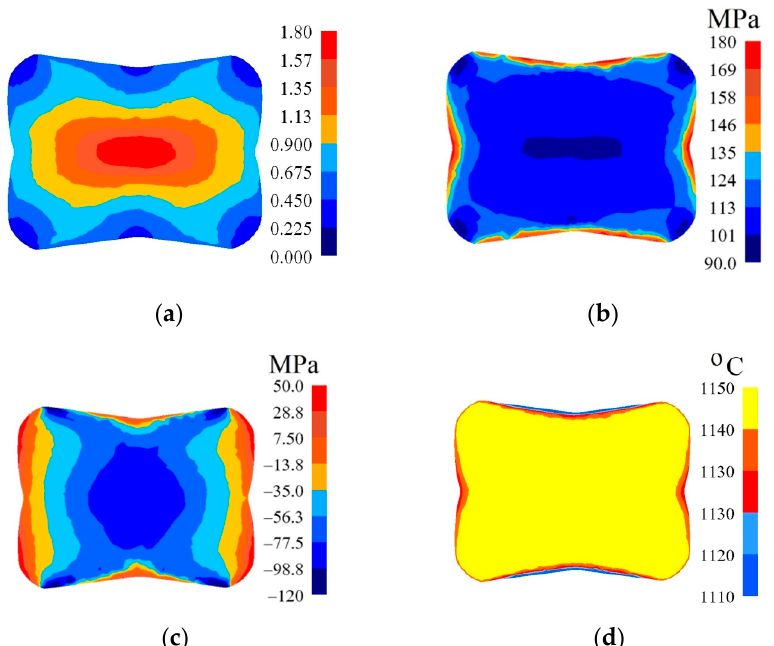
Figure 12. Distribution of the effective strain ( a ), effective stress ( b ), mean stresses ( c ), and temperature ( d ) on the cross-section of the workpiece in the course of forging in convex anvils after the second pass ( α c = 165°, ε c = 0.51).